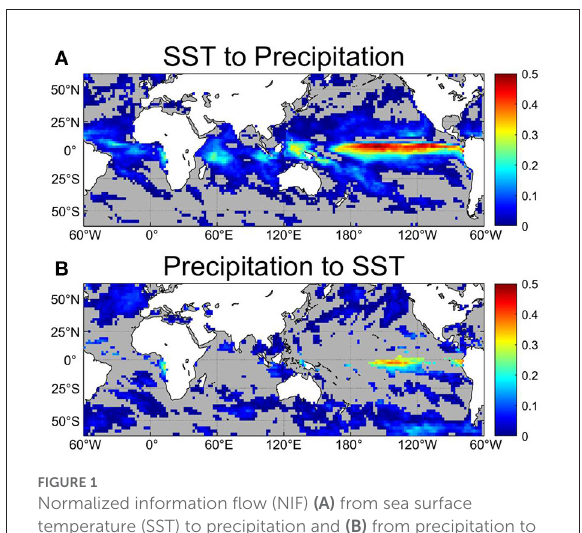
FIGURE1 Normalized information flow (NIF) (A) from sea surface temperature (SST) to precipitation and (B) from precipitation to SST. Gray grid cells signify that the NIF is not significant at the 95% confidence